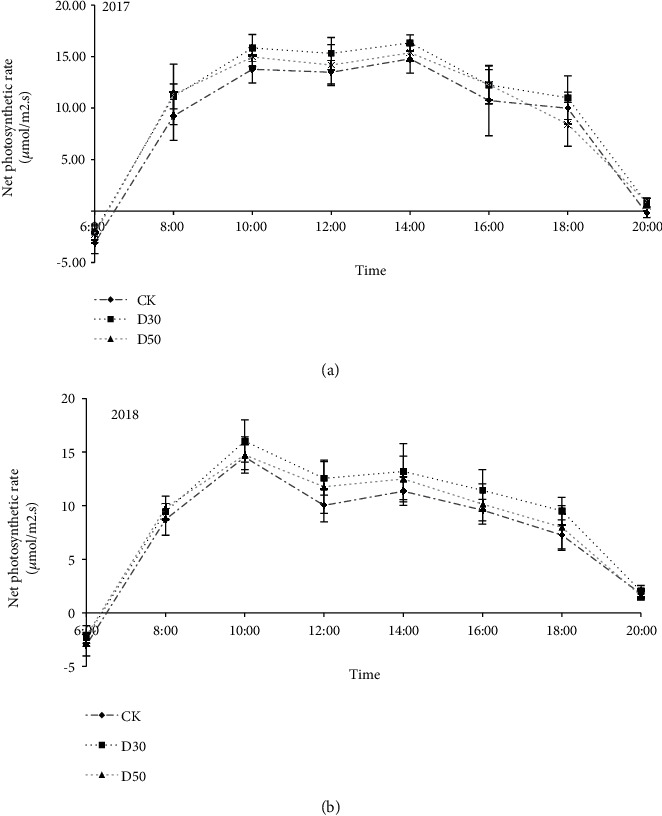
The NPR measurement. (a) and (b) Show the NPR results in 2017 and 2018, respectively. The x-axis represents time, and the y-axis represents NPR values. Different types of lines represent different groups.